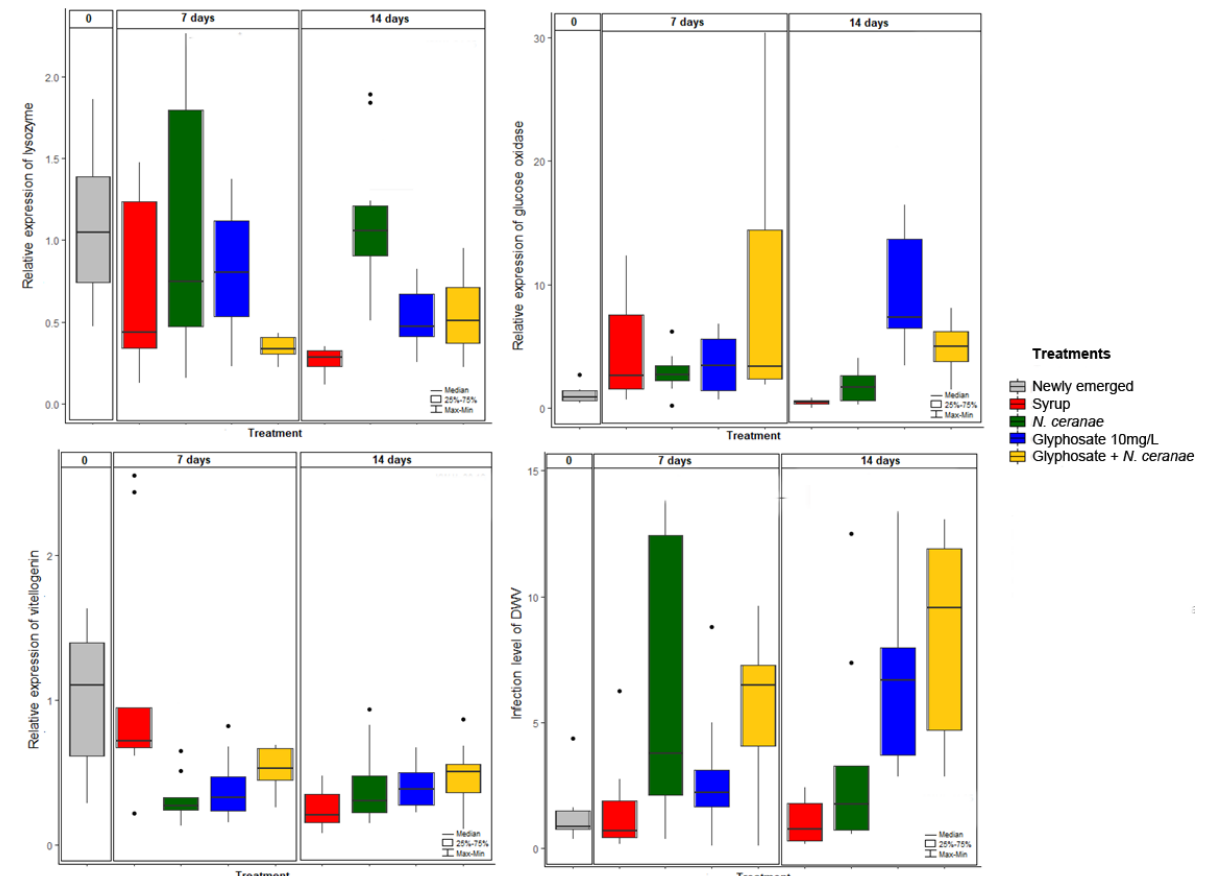
Figure 4. Impact of chronic exposure to glyphosate (10 mg/L), N. ceranae (100,000 spores/bee at day 0), and both stress factors combined on honey bee immunity (lysozyme, glucose oxidase), vitellogenin and DWV infection level evaluated using qPCR. Twelve honey bees per treatment (four bees per cage, from three independent cages) were individually sampled and analyzed at 0, 7 and 14 days of exposure. Relative quantification was performed using honey bee’s RPS5 as a reference gene. Results are shown as box plots, including median, 25 and 75% quartiles and outliers’ values.